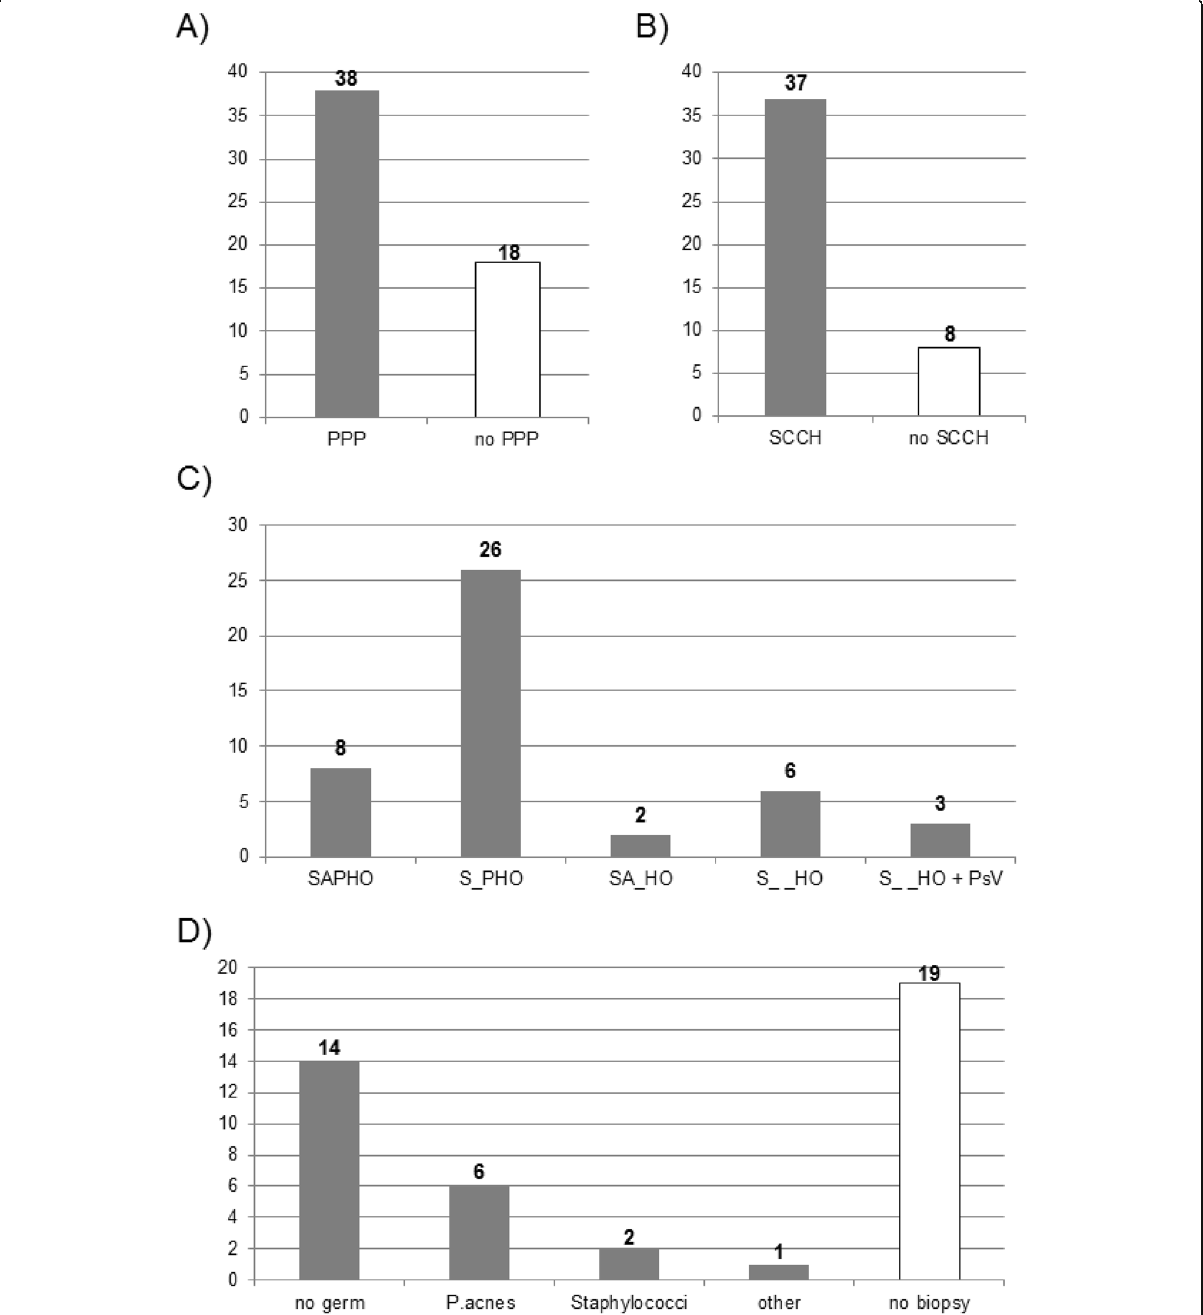
Fig. 1 Clinical characteristics in CRMO and SAPHO syndrome patients. a Number of patients with/ without palmoplantar pustular psoriasis (PPP). b Number of SAPHO syndrome patients with sterno-costo-clavicular hyperostosis (SCCH). c Number of SAPHO syndrome patients fulfilling all or part of the clinical characteristics included in the acronym SAPHO (syndrome of synovitis acne pustulosis hyperostosis osteitis). d Number of bone biopsies performed in 23 SAPHO syndrome patients with (lack of) detection of germs and number of patients ( n = 19) who did not have bone biopsies. P. acnes = Proprionibacterium